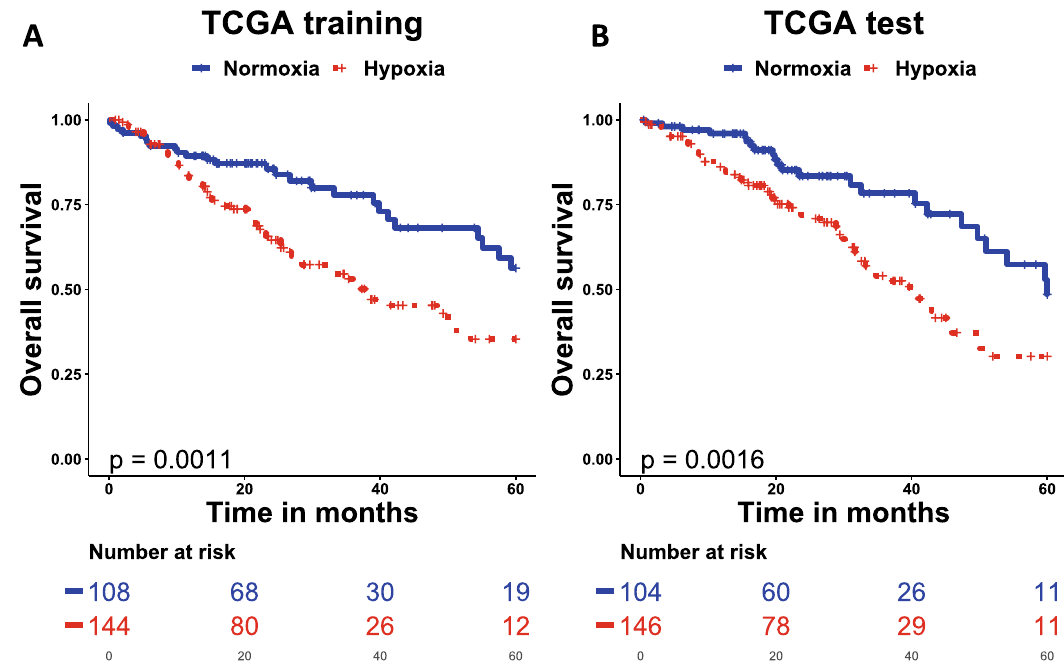
Figure 2. A 28-gene lung adenocarcinoma signature was prognostic for overall survival in TCGA LUAD. Patients with tumours stratified as hypoxic had worse overall survival in both TCGA LUAD training ( A ) and test ( B ) datasets. Patients were assigned to hypoxia or normoxia group based on the shrunken centroids. TCGA LUAD The Cancer Genome Atlas lung adenocarcinoma.